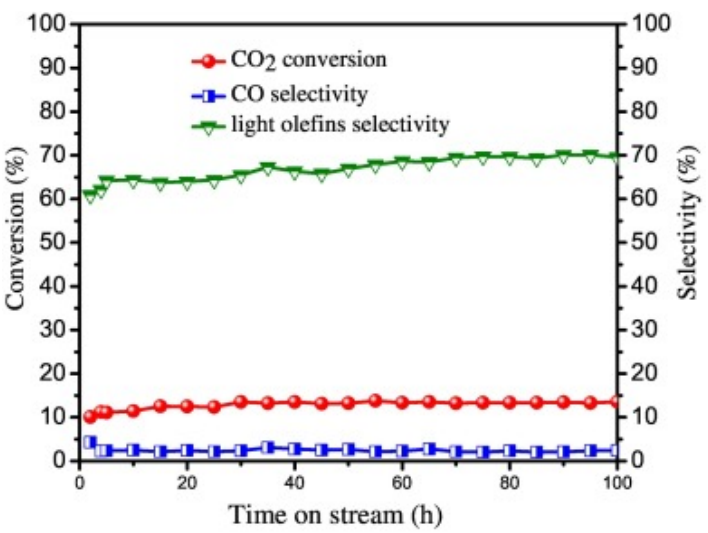
Figure 12. Catalytic behavior of the In 2 O 3 /ZrO 2 &SAPO hybrid catalyst in CO 2 hydrogenation during long-term activity test. Reaction conditions were: 300 °C, 2 MPa and GHSV of 2160 cm 3 h − 1 g cat − 1 . Reproduced from Ref. [97] with copyright license from Elsevier (2021).